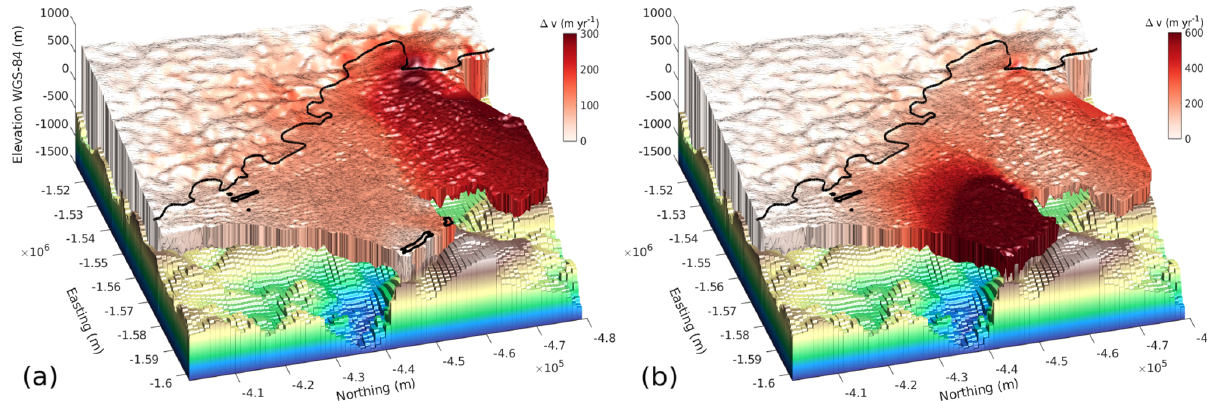
Figure 9. The effect of sustained ungrounding between the two remaining portions of Thwaites pinning point on regional ice dynamics, as modeled with ISSM. The black line shows the 2011 grounding line. (a) The black line shows the spatial extent of ungrounding and is guided by our analysis of height above flotation from ICESat-2. Note the funneling of ice over the bathymetric saddle and the increase in ice flow velocities on the Eastern Ice Shelf and further upstream. (b) Modeled acceleration following the entire ungrounding of the Eastern Ice Shelf from the pinning